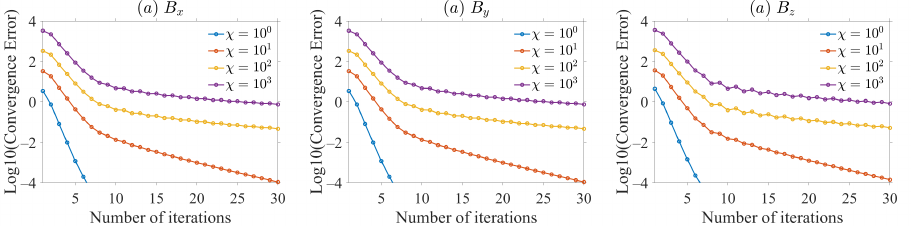
Figure 7. Convergence errors in B x , B y and B z versus the number of iterations at different mag- netic susceptibilities.